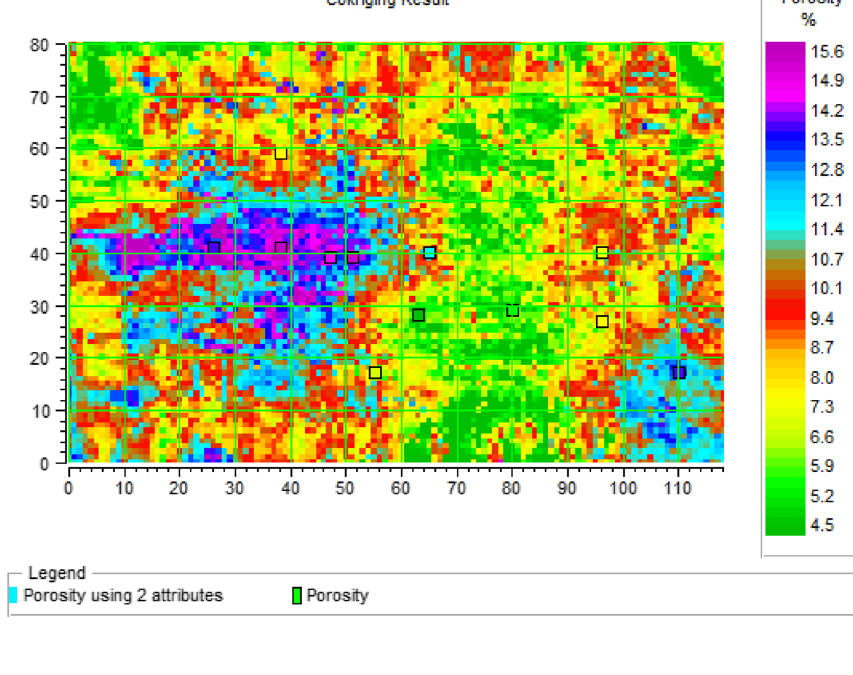
Fig. 37 Map of estimation error